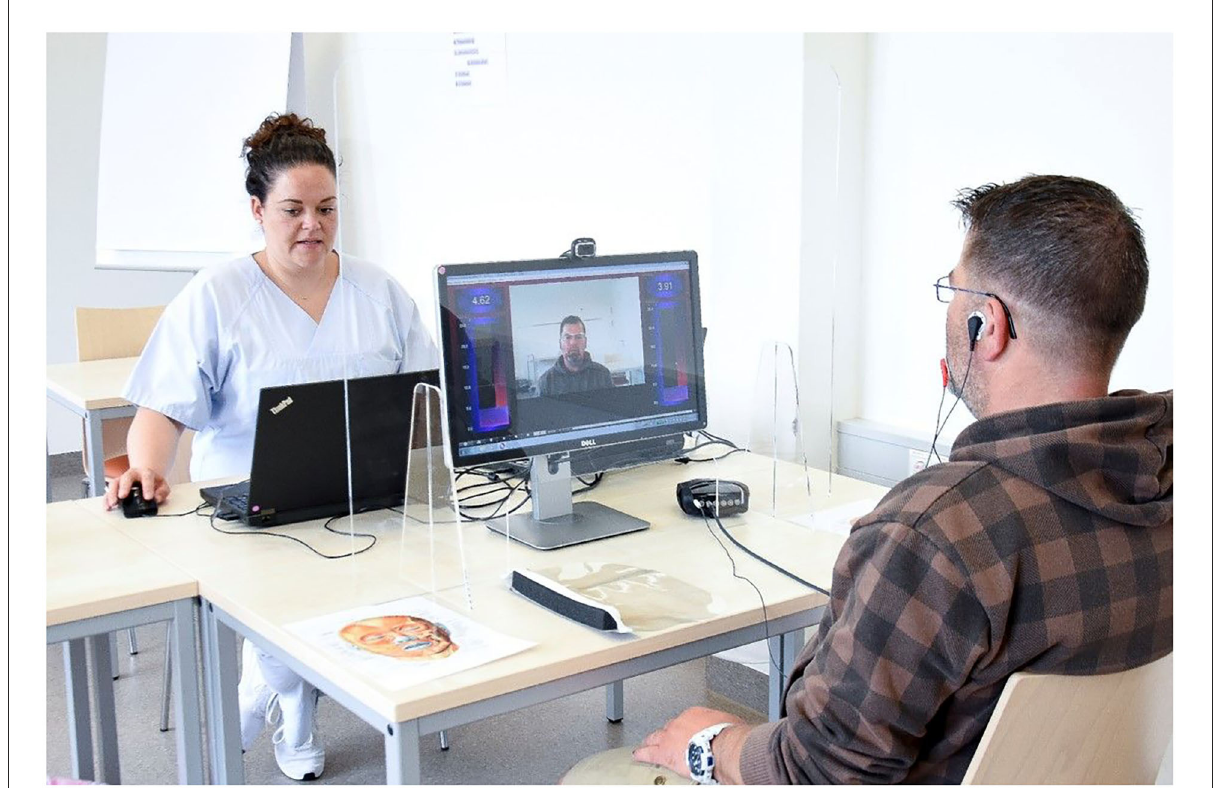
FIGURE3 Optimal therapy setting for EMG feedback-based training. The patient is sitting in the front (right side) . Surface EMG electrodes are positioned on the training muscle (to be activated) and a synkinetic muscle (not to be activated). The patient sees himself on the computer screen, while the muscle activity is visualized in pseudo colors as activity bars. The therapist in the back (left side) sees the same information as the patient and is guiding the patient through the different mimic movement tasks.